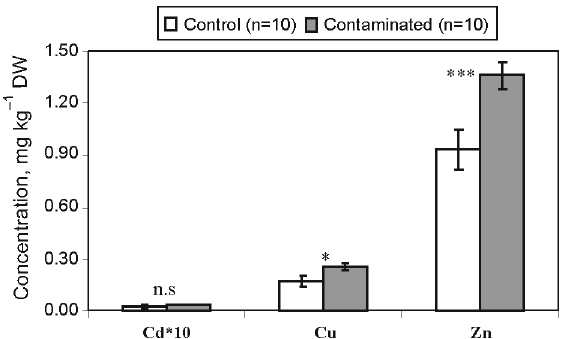
n – number of wood samples; significant differences between plots: * – p > 0.05 and *** – p < 0.001; n.s. – non significant differences. Fig. 6. Concentration of Cd, Cu and Zn in wood on both control and contaminated plots. Values are means ±SD (vertical